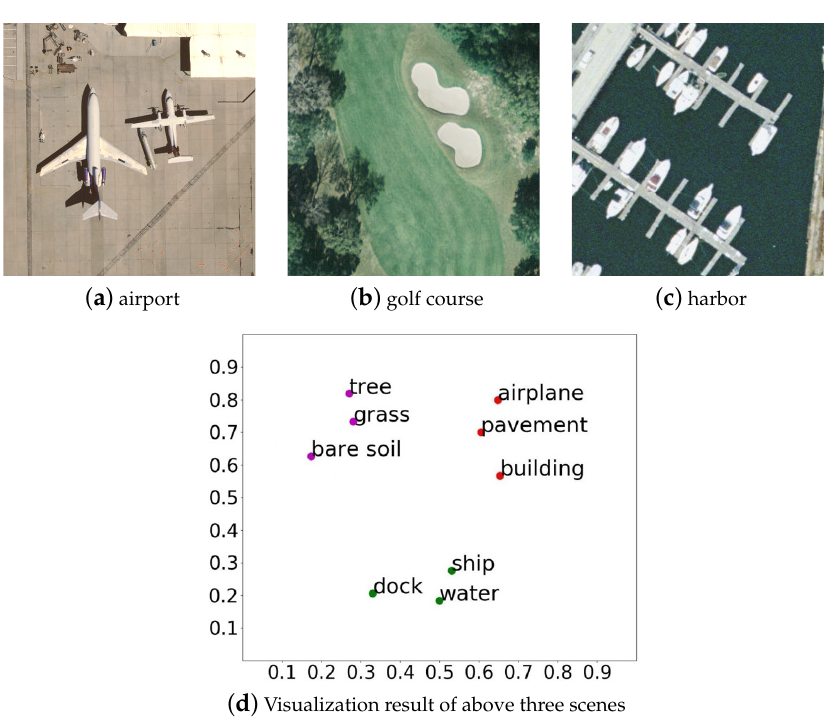
Figure 4. Three remote sensing scenes and the corresponding t-SNE [68] visualization.